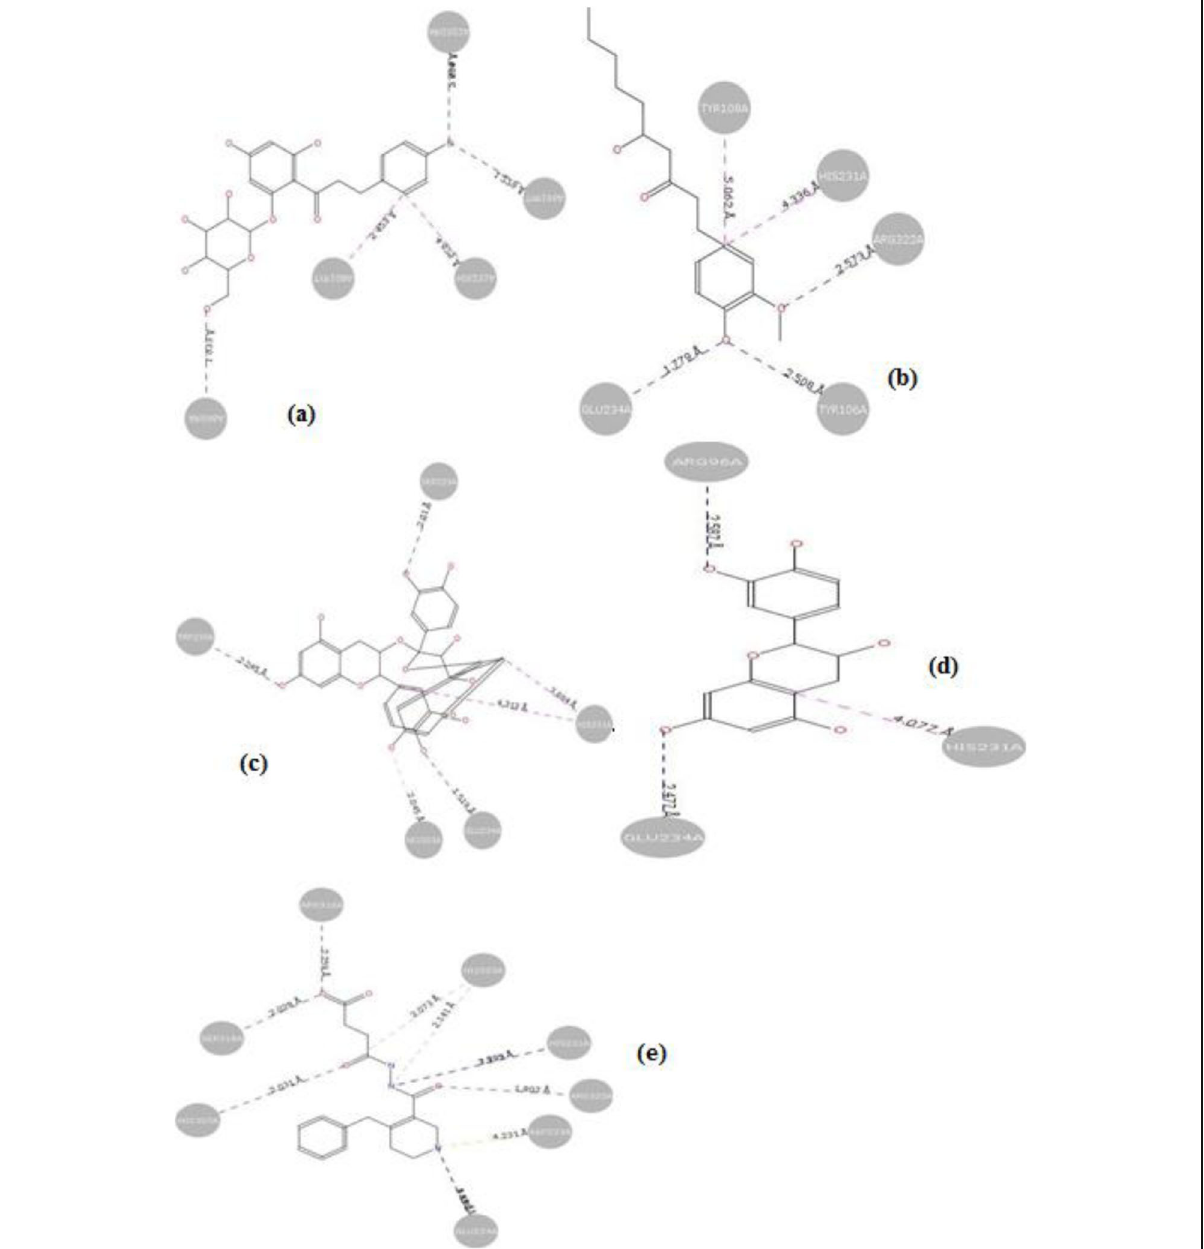
Fig. 8 ( a ) Hydrogen bonding and aromatic interactions of phlorizin with cocrystallized ligand-tracked active site in 4CXW. ( b ) Hydrogen bonding and aromatic interactions of 6-gingerol with cocrystallized ligand-tracked active site in 4CXW. ( c ) Hydrogen bonding and aromatic interactions of procyanidin with cocrystallized ligand-tracked active site in 4CXW. ( d ) Hydrogen bonding and aromatic interactions of epicatechin with cocrystallized ligand-tracked active site in 4CXW. ( e ) Hydrogen bonding and charge interactions of reference ligand with cocrystallized ligand- tracked active site in